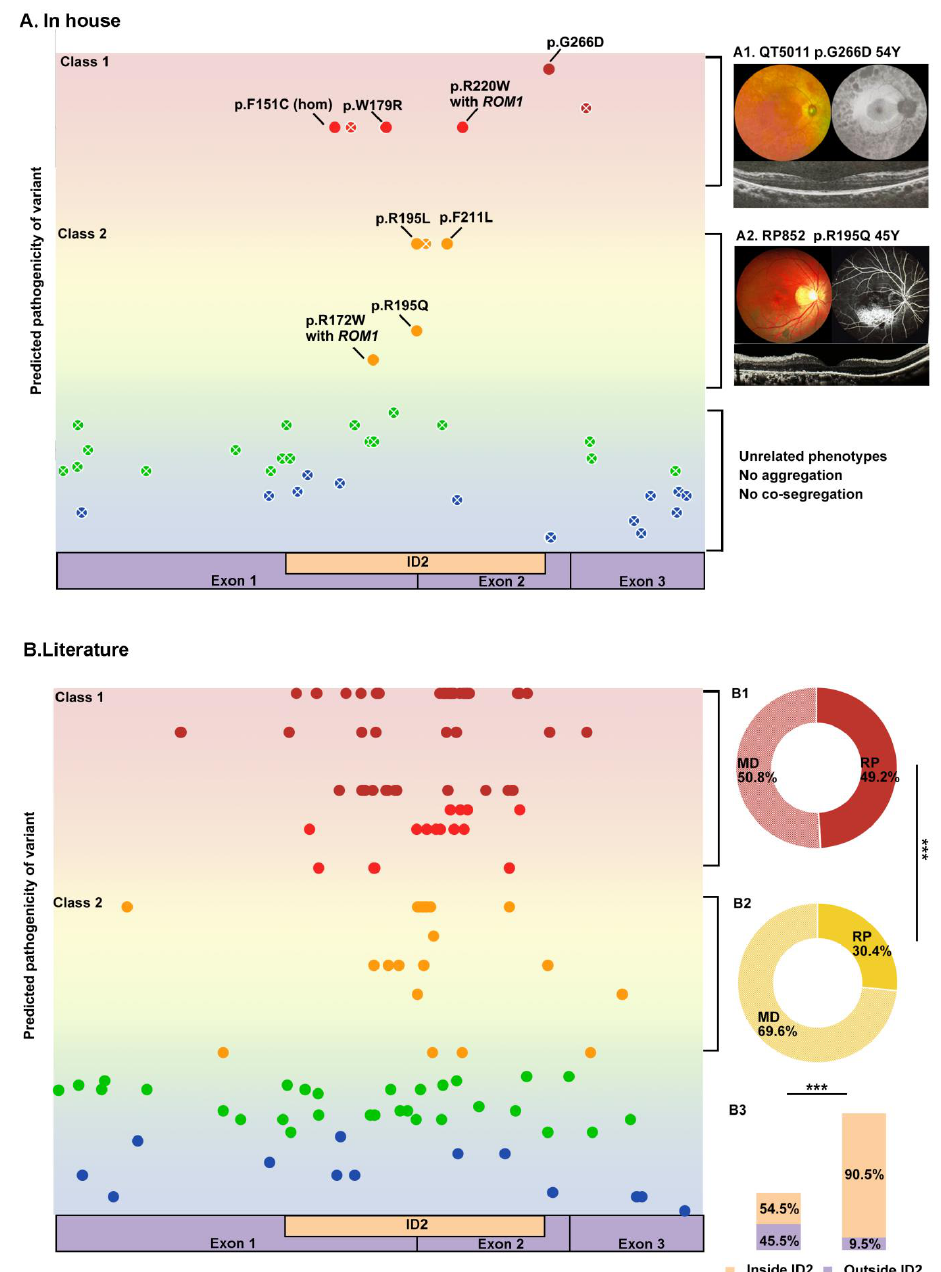
Figure 4. The exploration of the correlation between genotype and phenotype of PRPH2 -associated diseases in this study. ( A ) In our cohort, among the four patients carrying missense variants that were predicted by at least six out of the seven in silico tools and absent in the gnomAD database (Class 1), three were diagnosed with retinitis pigmentosa ( A1 ). Among the remaining four patients carrying missense variants predicted as damaging by five tools and absent in the gnomAD database or predicted as damaging by six tools and containing one allele number in the gnomAD database, three were identified with macular degeneration ( A2 ). Patients carrying missense variants predicted to be benign by more than three tools and with more than one allele number in the gnomAD database presented phenotypes unrelated to PRPH2 that were not co-segregated among family members and were not aggregated among individuals with inherited retinal dystrophy compared to controls. ( B ) In total, 49.1% of the 254 families carrying Class 1 missense variants were diagnosed with retinitis pigmentosa ( B1 ), while 69.6% of the 102 families with Class 2 missense variants were diagnosed with macular degeneration ( B2 ), which was statistically significant ( p = 0.001). Among all of